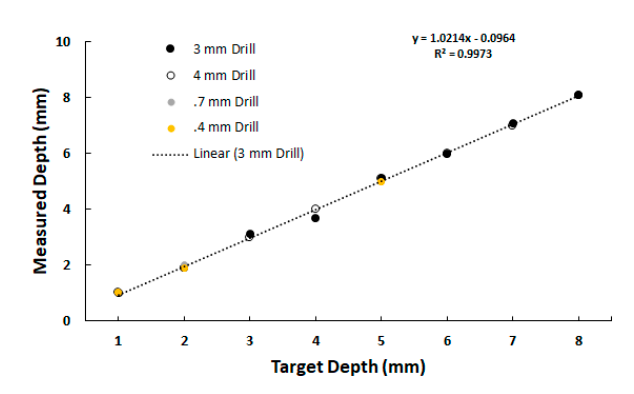
Figure 5. Accuracy in drilling different target depth ranging from 1 mm–8 mm using multiple